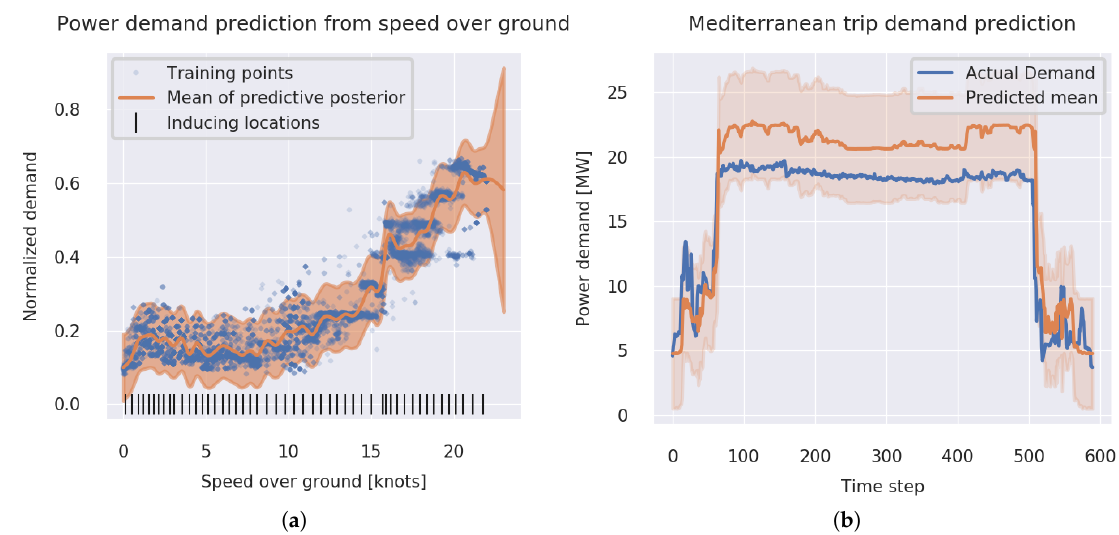
Figure 3. Fitted Gaussian Process to predict demand from speed over ground and inducing locations that summarize the larger set of measured points ( a ) and Gaussian process demand prediction for one Mediterranean trip ( b